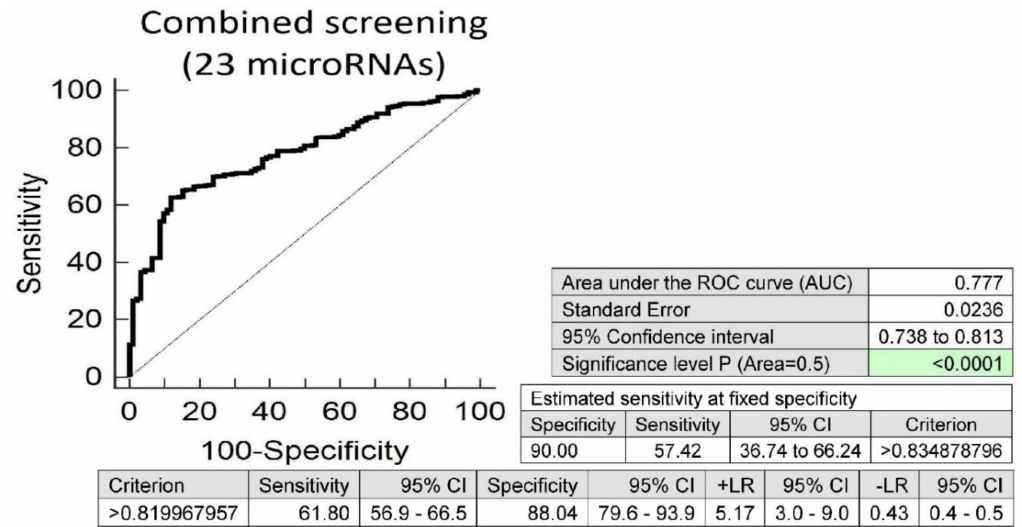
Figure 1. Aberrant microRNA expression profile in children descending from complicated pregnancies, irrespective of the type of pregnancy-related complication (gestational diabetes mellitus, gestational hypertension, preeclampsia, fetal growth restriction, preterm prelabor rupture of membranes and / or spontaneous preterm birth). Combined screening revealed that at a 10.0% false positive rate (FPR) 57.42% children prenatally exposed to any pregnancy-related complication had substantially altered microRNA expression profile (miR-1-3p, miR-16-5p, miR-17-5p, miR-20a-5p, miR-20b-5p, miR-21-5p, miR-23a-3p, miR-26a-5p, miR-29a-3p, miR-100-5p, miR-103a-3p, miR-125b-5p, miR-126-3p, miR-130b-3p, miR-133a-3p, miR-143-3p, miR-146a-5p, miR-181a-5p, miR-195-5p, miR-199a-5p,